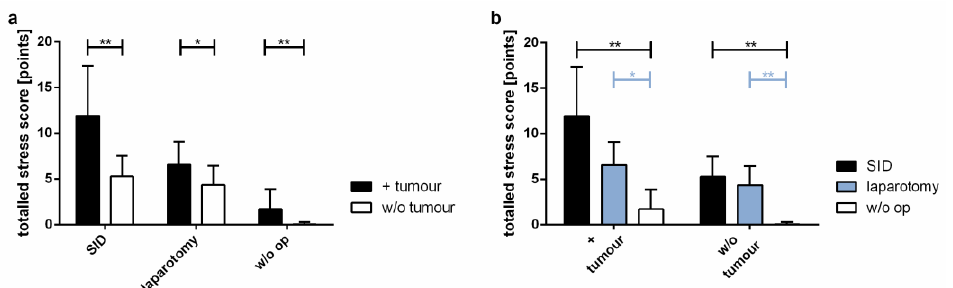
Figure 2. Statistical evaluation of the stress level. A stress score including physical appearance, respiration, spontaneous behaviour, and elicited behaviour was assessed every day to survey the influence of the tumour and/or the surgical procedure on the general condition. The graphic shows the stress scores of 28 days. ( a ) Comparison of tumour vs. w/o tumour in SID, laparotomy or in w/o operation; ( b ) comparison of SID vs. laparotomy vs. w/o operation in tumour-bearing mice and in tumour-free mice. Values represent the mean and standard error; n = 9 – 15 (SID + tumour: n = 11; laparotomy + tumour: 9; w/o op + tumour: 11; SID: 11; laparotomy/control: 15); * p < 0.05; ** p < 0.01.